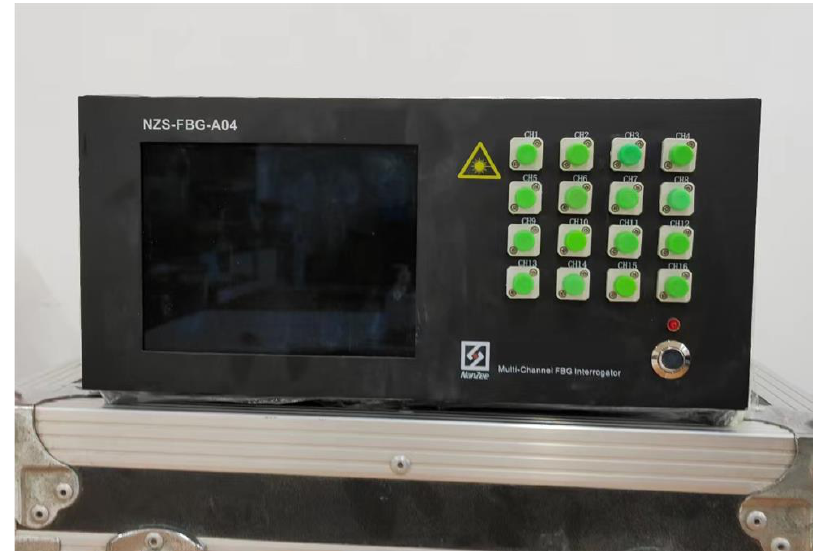
Figure 4. NZS-FBG-A04 multichannel fiber grating demodulator.